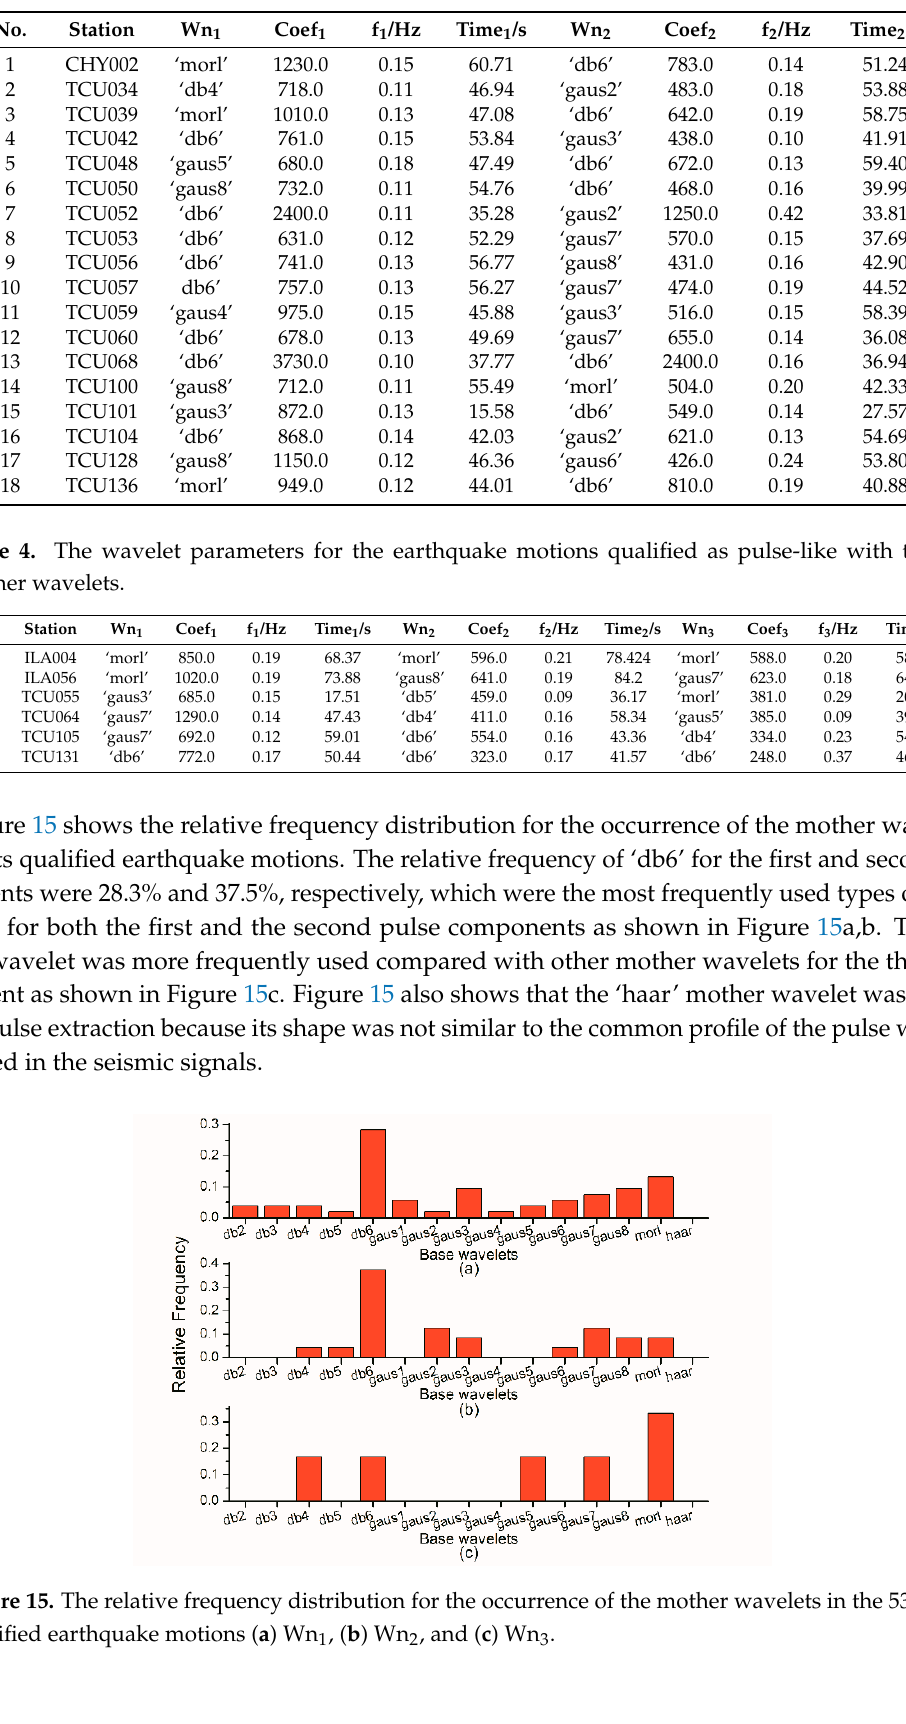
Table 3. The wavelet parameters for the earthquake motions qualified as pulse-like with two mother wavelets.